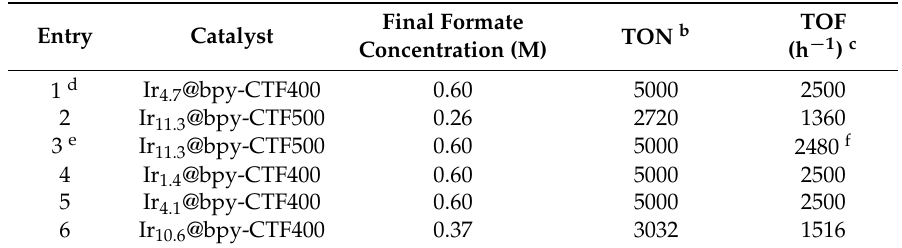
Table 2. Catalytic Performances of catalysts Ir 11.3 @bpy-CTF500, Ir 1.4 @bpy-CTF400, Ir 4.1